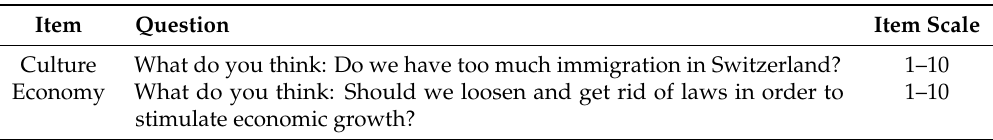
Table 2. Operationalization of political cleavages.